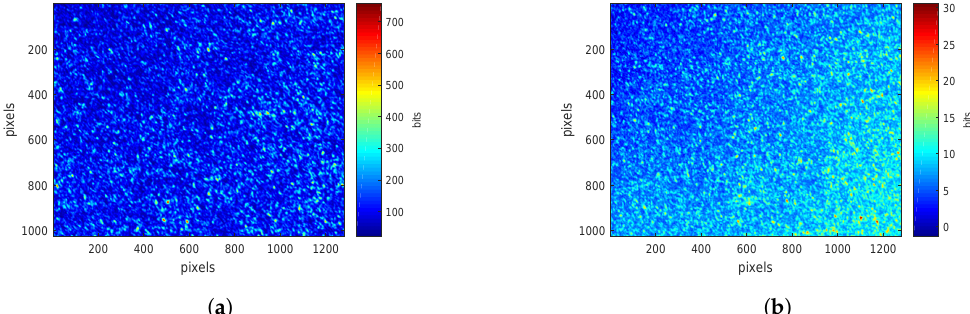
Figure 2. Speckle patterns at 660 nm for ( a ) pp -polarization ( b ) ps -polarization with a color scale defined by the minimum and maximum values of pixels.